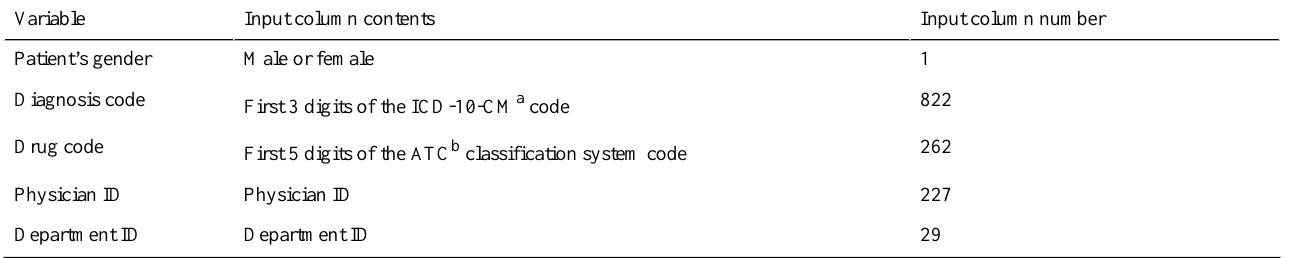
Table 1. List of input